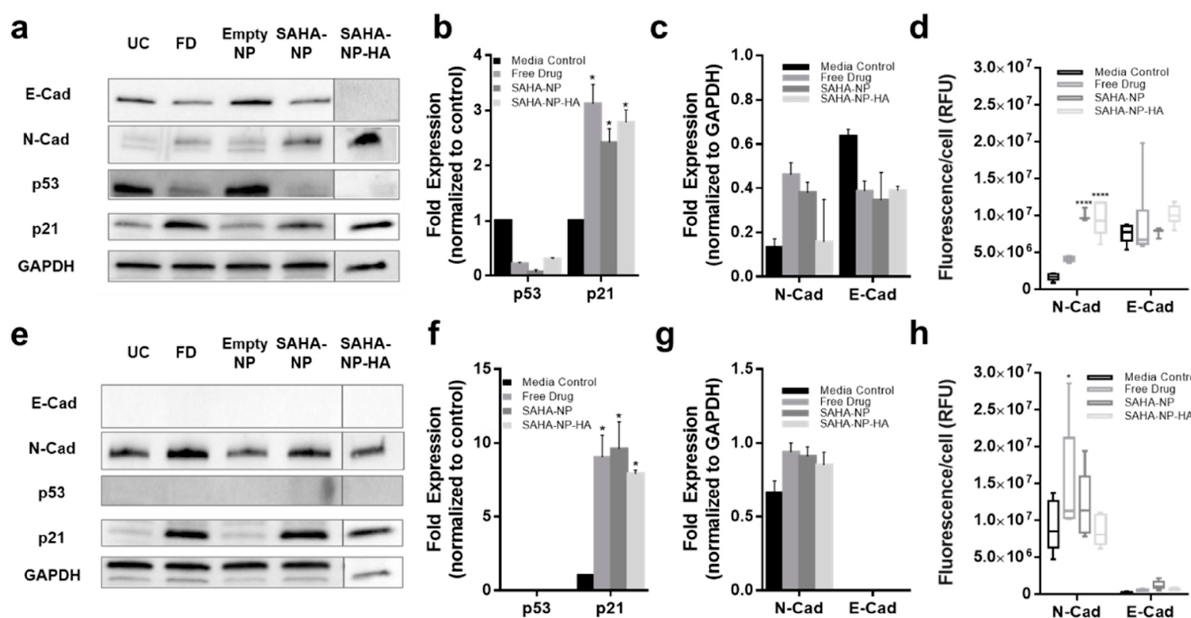
Figure 6. SAHA and SAHA-NP systems alter p21 and p53 expression and molecular in endometrial cancer cells. Protein blots for Ishikawa ( a ) (original images can be found at Figure S10) and Hec50 ( e ) (original images can be found at Figure S11), and densitometry for media control (black) and 2.5 µ M SAHA (medium grey), SAHA-NP (dark grey) and SAHA-NP-HA (light grey) for 48 h for p53 and p21 in Ishikawa ( b ) and Hec50 ( f ) and E and N cadherin in Ishikawa ( c ) and Hec50 ( g ). * p53 and p21 are average and standard error, from a minimum of three independent repeats normalized to the untreated controls and GAPDH protein density. Cadherin values are average and standard error from a minimum of three independent repeats normalized to GAPDH protein density level only. Cadherin expression in endometrial cancer models. Immunofluorescence of E and N-cadherin in Ishikawa ( d ) and Hec50 ( h ) cell lines following 48 h treatments, relative fluorescence units (RFU) values obtained from ImageJ analysis of immunofluorescence images ( n = 6), RFU per cell based on nuclei count. Statistical significance is indicated on graphs: p ≤ 0.05 denoted by * and p ≤ 0.0001 by ****.